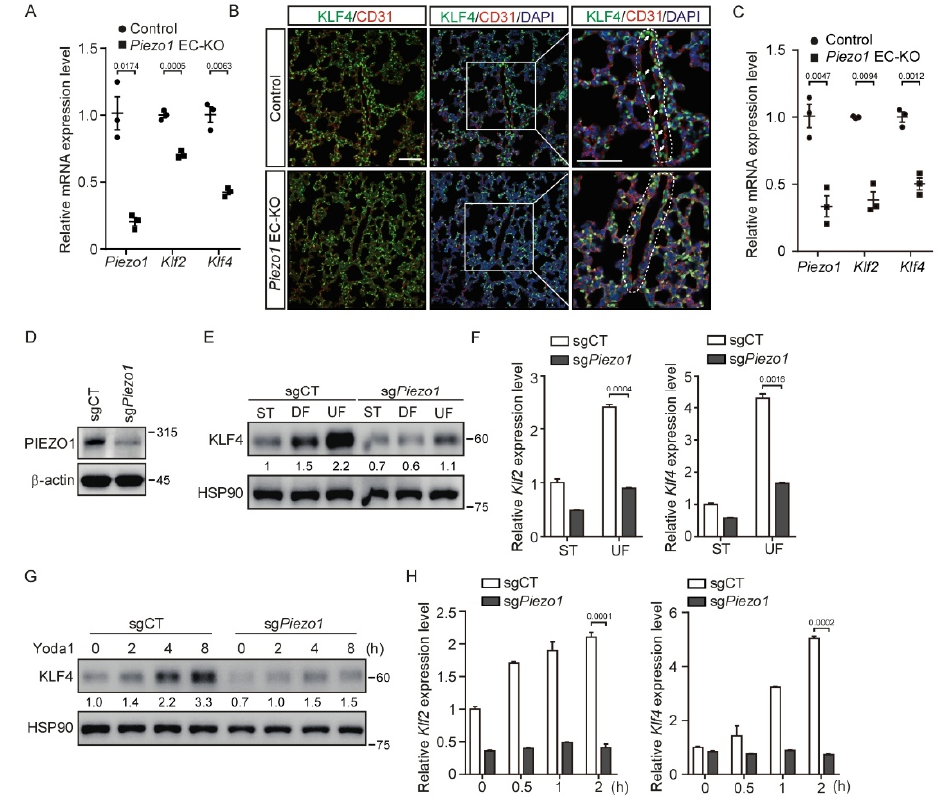
Figure 2. Deletion of PIEZO1 in endothelial cells impairs KLF2/4 expression induced by shear stress. ( A ) Thoracic aortas of Piezo1 fl/fl and Tie2Cre ; Piezo1 fl/fl mice at P10 were collected, and mRNA expres- sion levels of Piezo1 , Klf2 and Klf4 were measured by quantitative RT-PCR. n = 3 mice/each group. ( B ) Representative immunofluorescence staining of lungs from Piezo1 fl/fl and Tie2Cre ; Piezo1 fl/fl mice in the same litter for CD31 (red), KLF4 (green) and nuclei (blue). Arrows indicate the KLF4 expressing endothelial cells. Dotted lines outline the blood vessel. Scale bars are 50 μm. n = 3 mice/ each group. ( C ) Primary mouse brain endothelial cells from Piezo1 fl/fl and Tie2Cre ; Piezo1 fl/fl mice at 4 weeks were isolated, and mRNA levels of Piezo1 , Klf2 and Klf4 were measured by quantitative RT-PCR. n = 3 mice/each group. ( D ) Control and Piezo1 -dificient MBMECs were harvested, and cell lysates were probed with anti-PIEZO1 antibody. ( E , F ) Control and Piezo1 -dificient MBMECs were exposed to shear stress for 5 days. KLF4 proteins ( E ) and mRNA levels of Klf2 and Klf4 ( F ) were monitored by western blotting and quantitative RT-PCR, respectively. ( G , H ) Control and Piezo1 -dificient MBMECs were treated with Yoda1 (5 μM) for the indicated time. KLF4 proteins ( G ) and mRNA levels of Klf2 and Klf4 ( H ) were monitored by western blotting and quantitative RT-PCR, respec- tively. Data are representative of three independent experiments and are presented as mean ± SEM of three technical replicates by an unpaired Student’s t -test ( F , H ). The immunoblot was measured using ImageJ to determine the relative intensities of the indicated bands, which were normalized using the internal loading control proteins. The relative intensities are shown as numbers. ST: static culture; UF: unidirectional laminar flow.